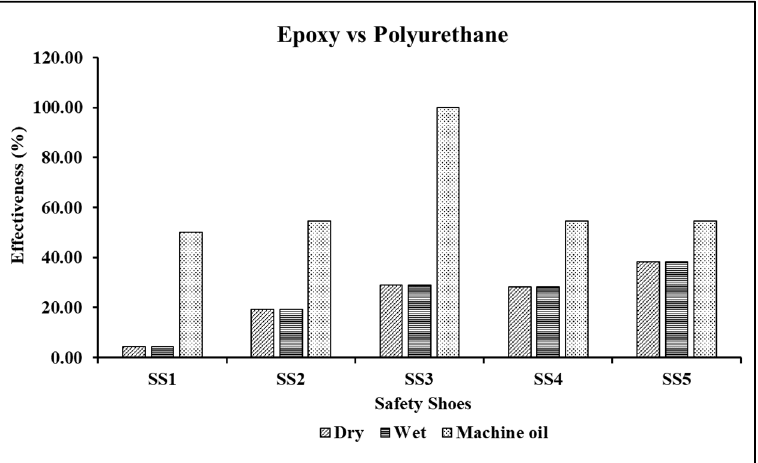
Figure 13. Effectiveness improvement of polyurethane-based coating as compared to epoxy-based flooring across dry, wet, and machine oil contaminant